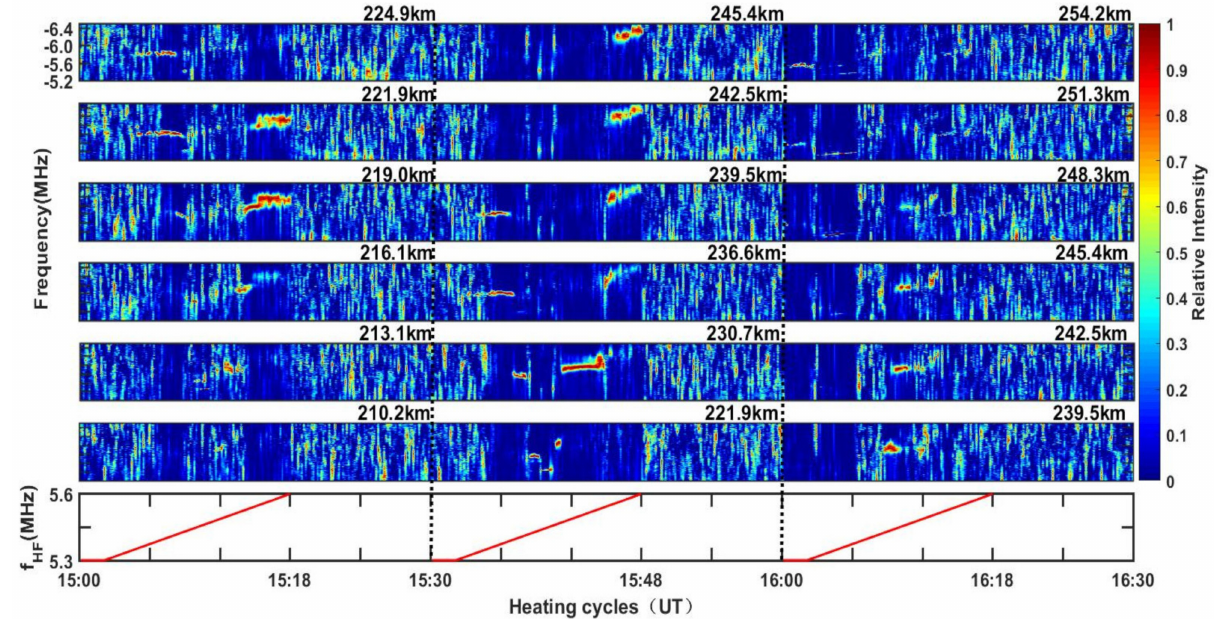
Figure 3. The downshifted plasma lines from − 5.5 MHz to − 6.5 MHz at different